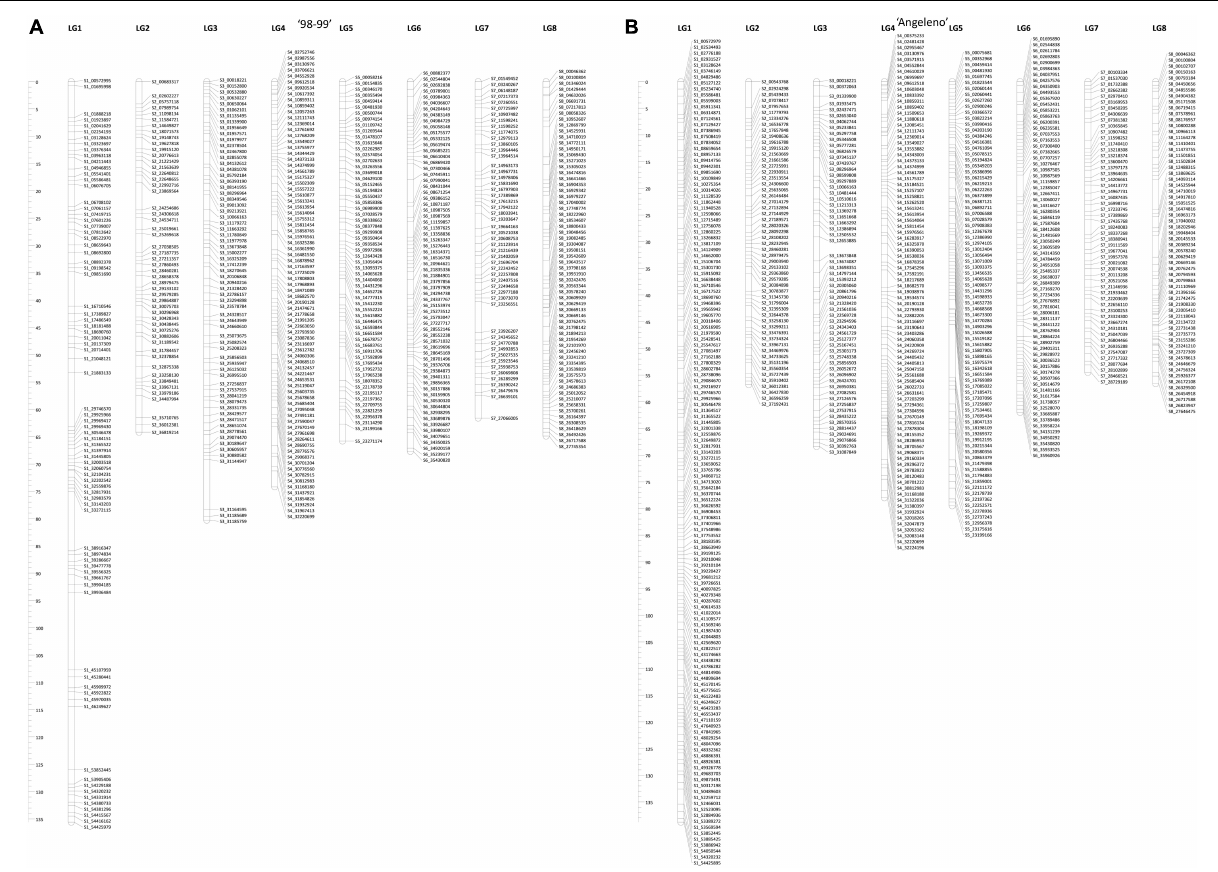
FIGURE 5 | Linkage maps for each parent in the F1 Japanese plum population, ‘98–99’ (A) and ‘Angeleno’ (B) . On the left are shown the genetic distances (cM) for each map. On the right of each LG is the name of each SNP. The name of the SNPs indicates the corresponding LG and the physical position according to the Prunus salicina Lindl. reference